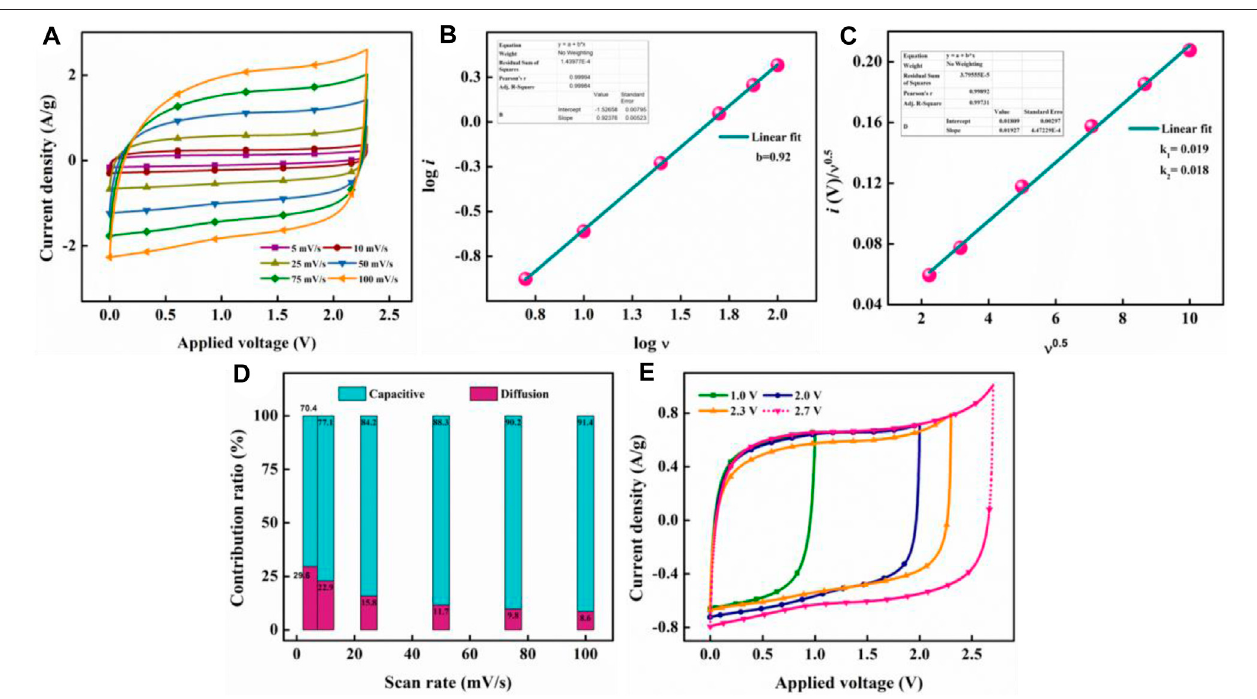
FIGURE 8 | CV pro fi le of OSSc at various current densities operated at 2.3 V (A) , plot of linearity of log i with sweep rate (B) , linearity plot of current response with scan rate for fi nding k 1 and k 2 (C) , quanti fi cation of current response from capacitive and diffusion-controlled mechanisms (D) , and CV depicting OSSc operated at different voltages at 25 mV/s, (E)